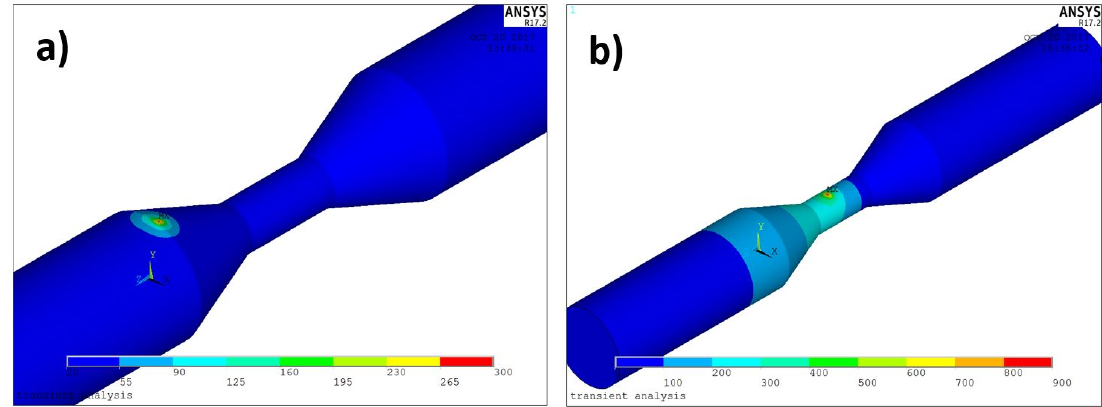
Figure 11. Temperature distribution during the hardening process of AISI 1040 steel specimen at two different times: ( a ) t = 1.5 s; ( b ) t = 16 s.